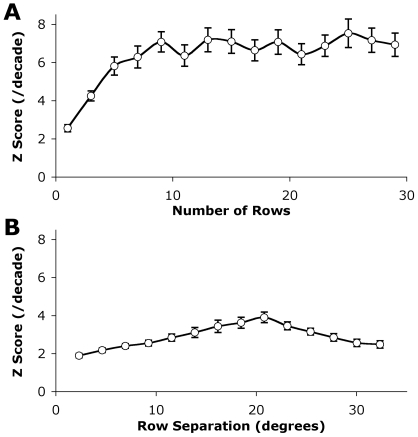
Effect of varying the vertical rows in global summation stage on velocity discrimination.A) The number of rows used in the global summation (stage 5 in Figure 2) was varied. In each case a row centered on the horizon was used and other rows were equally separated both above and below the horizon. Little improvement is gained by averaging more than 7 rows together. B) Only 3 rows were used in the calculation but the separation of the rows from the centre was varied. The optimal separation of rows occurred at approximately 21 degrees, i.e. rows at +21, 0 and −21 degrees with reference to the horizon. Due to the large amount of image similarity in the vertical dimension separations less than this resulted in samples that were not distinct enough to assist with velocity estimation. Values were calculated as the mean Z score across all velocity intervals used, error bars represent one standard error of the mean.